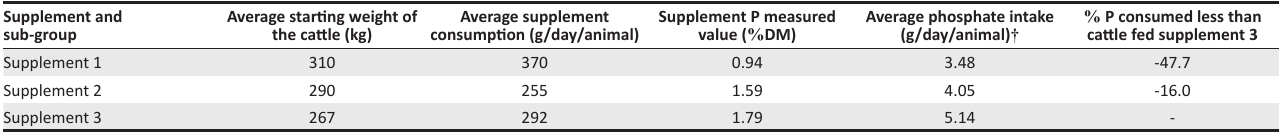
TABLE 3: Calculated average daily phosphate intake of respective sub-groups. Supplement and sub-group